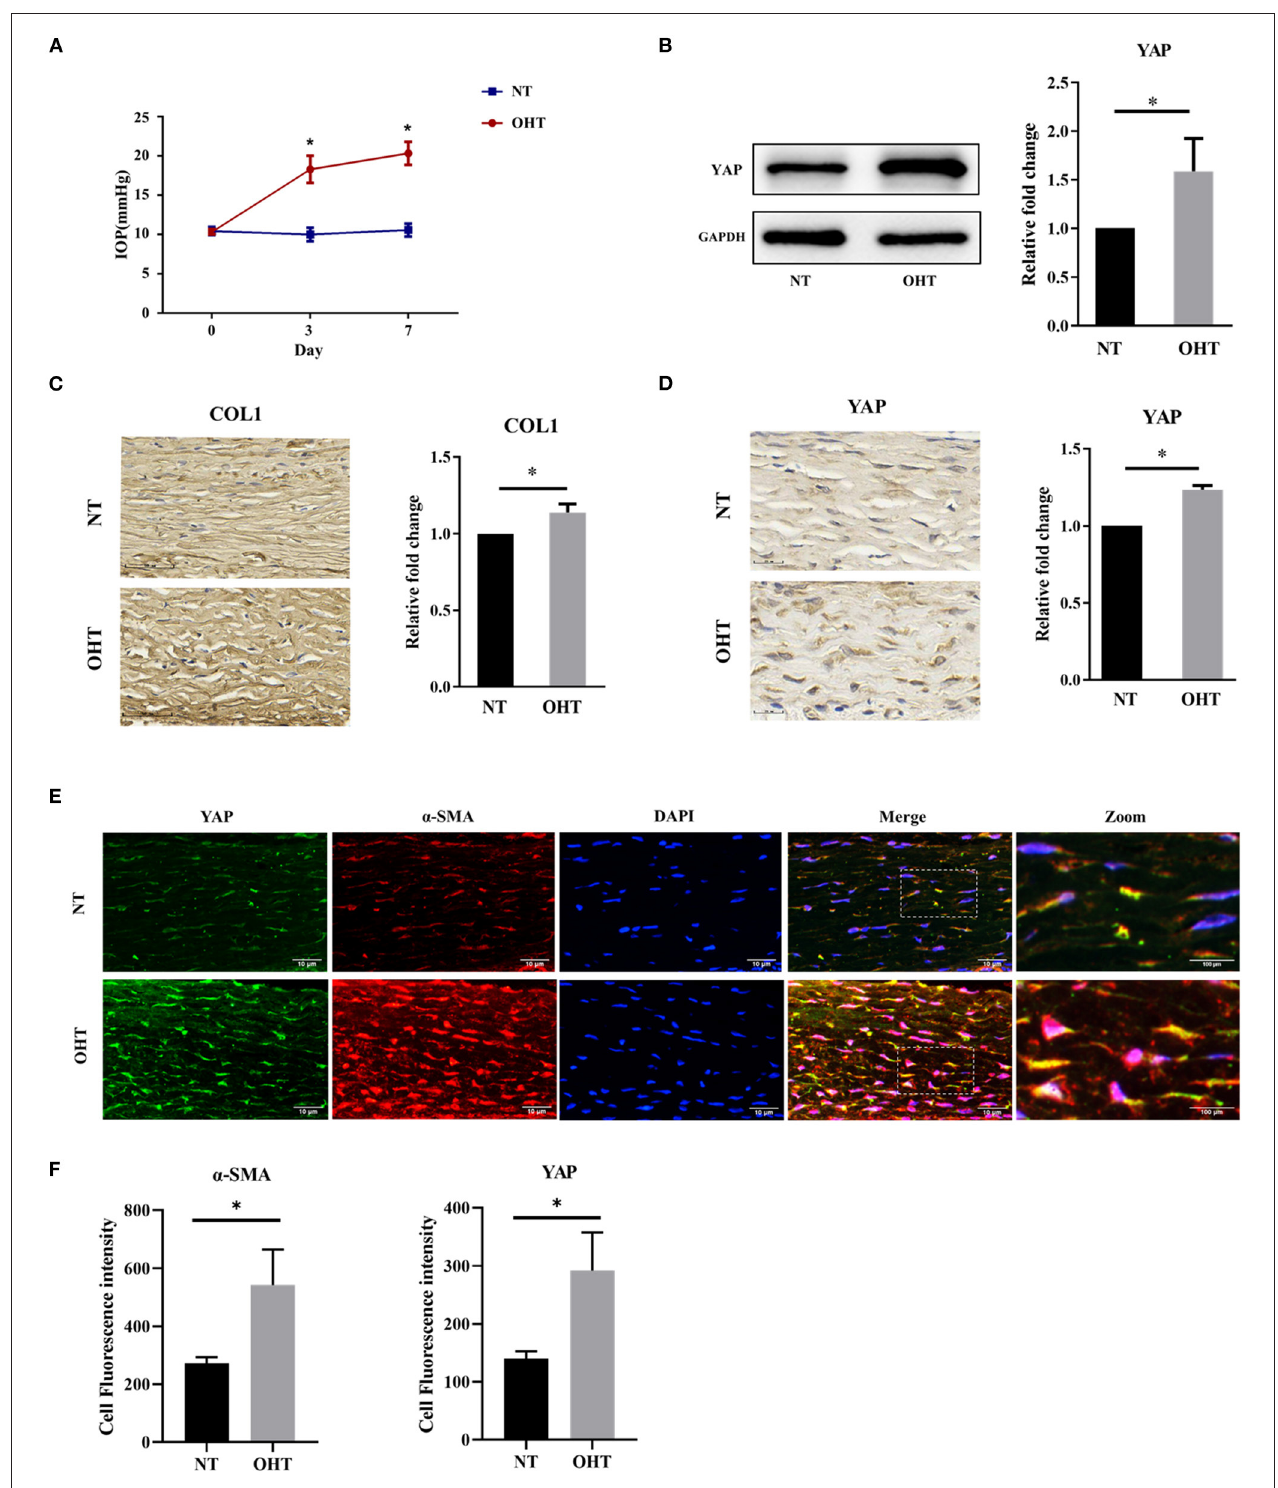
FIGURE 2 | Yap expression in the OHT model of SD rats. (A) Intraocular pressure (IOP) in the OHT model of SD rats. (B) Representative picture and quantitative analysis of immunofluorescent staining of COL1 in the OHT model of SD rats (scale bar = 50 um). (C) Representative pictures and quantitative analysis of immunofluorescent staining of YAP in the OHT model of SD rats (scale bar = 20 um). (D) Western blotting analyses of YAP in the OHT model of SD rats. (E) Representative picture of immunofluorescence of containing YAP and α -SMA in the OHT model of SD rats (scale bar = 10 um). (F) Quantitative analysis